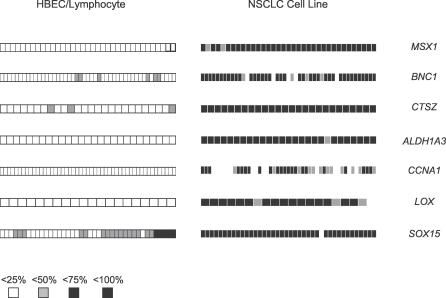
Summary of Sodium Bisulfite Sequencing for Seven Genes in PBCs, HBECs, and NSCLC CellsBetween eight and 20 clones were sequenced for each locus in each cell type. Sequencing primers were designed to flank the MSP priming sites and do not include any CpG sites, with the exception of BNC1, which we were not able to amplify outside of the MSP priming sites for cells that harbored methylation. There was no amplification of the methylated primer set in HBECs or PBCs, and no amplification of the unmethylated primer set in the NSCLC cell lines examined. One some occasions the methylated primer set for BNC1 amplified a 289 bp amplicon from an unrelated locus on Chromosome 1. The sequence corresponds to a CpG island in an intronless gene (GPR25) that was heavily methylated in tumors. The unmethylated primer set did not amplify this sequence. Each box represents a composite of clones for that CpG site. Open boxes indicate 0%–25% methylation; light grey, 26%–50%; dark grey, 51%–75%; black, 76%–100% methylation. Raw data are available in Figures S8–S14. Primers and PCR conditions are available upon request.